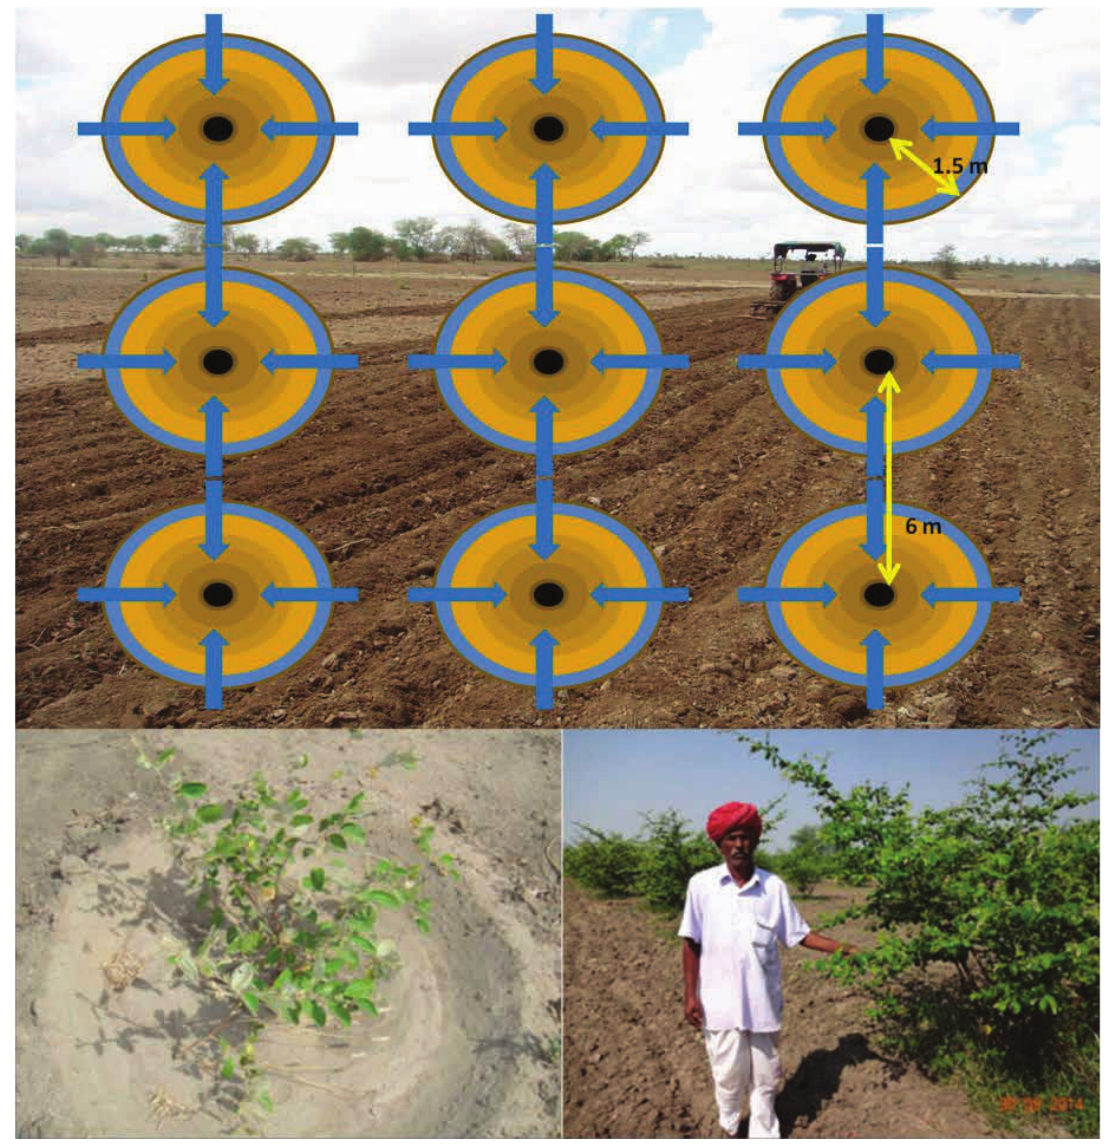
Figure 5: Circular water catchment in